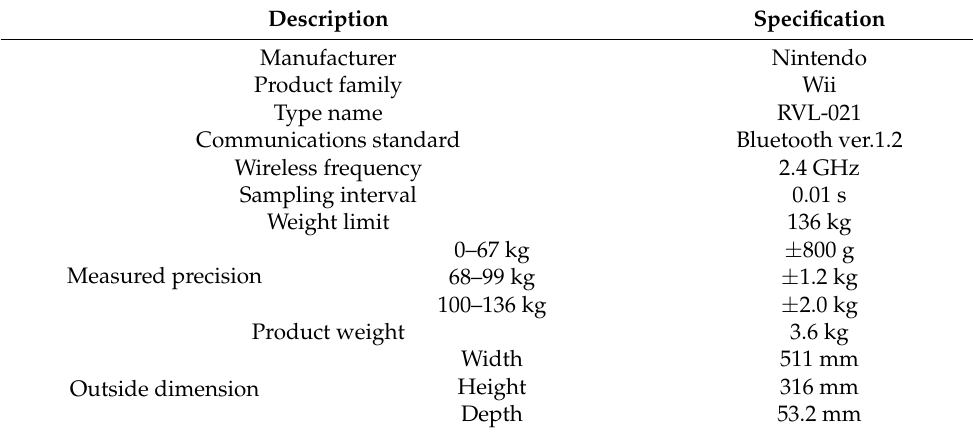
Table 2. Specifications of the Wii Balance